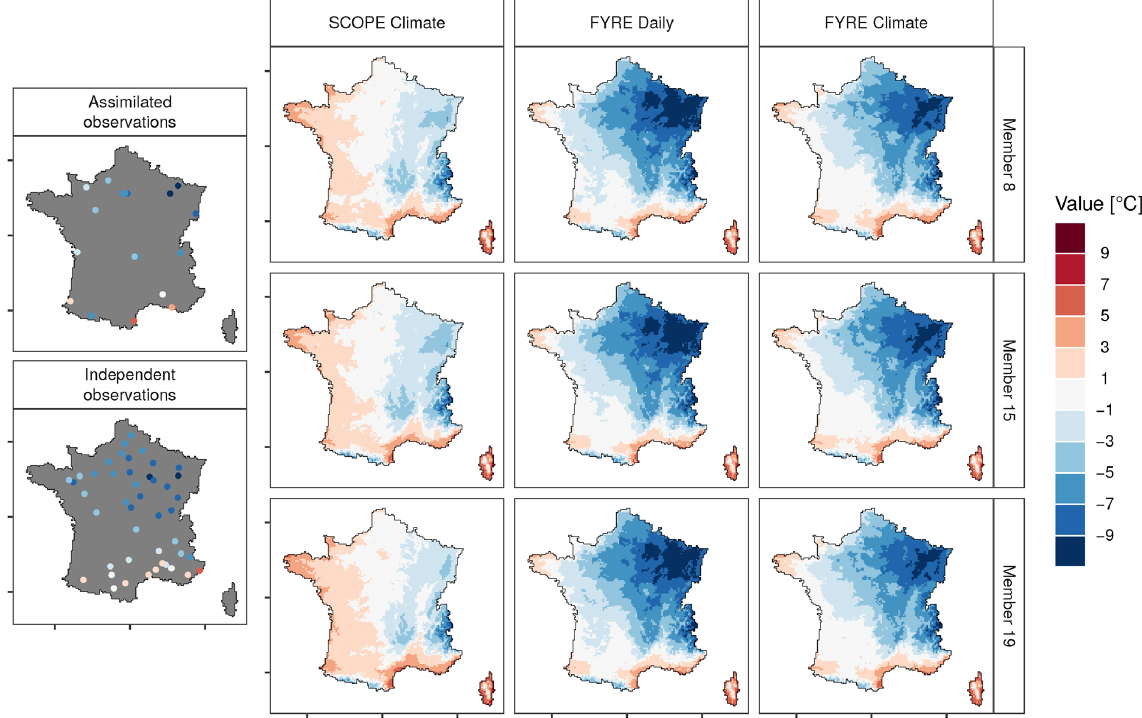
Figure 11. Average daily mean temperature in France during December 1879 from observations (left panels), and from three randomly selected members of SCOPE Climate/FYRE Daily/FYRE Climate (right panels).